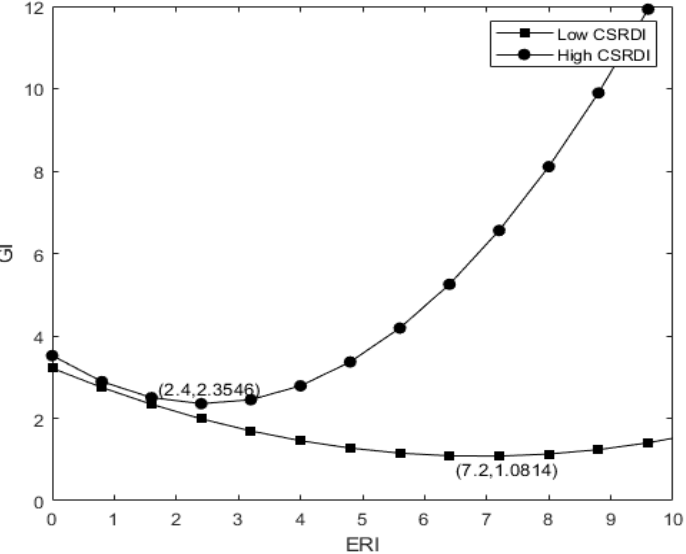
Figure 2. U-shaped relationship diagram between environmental regulation and enterprise green innovation.